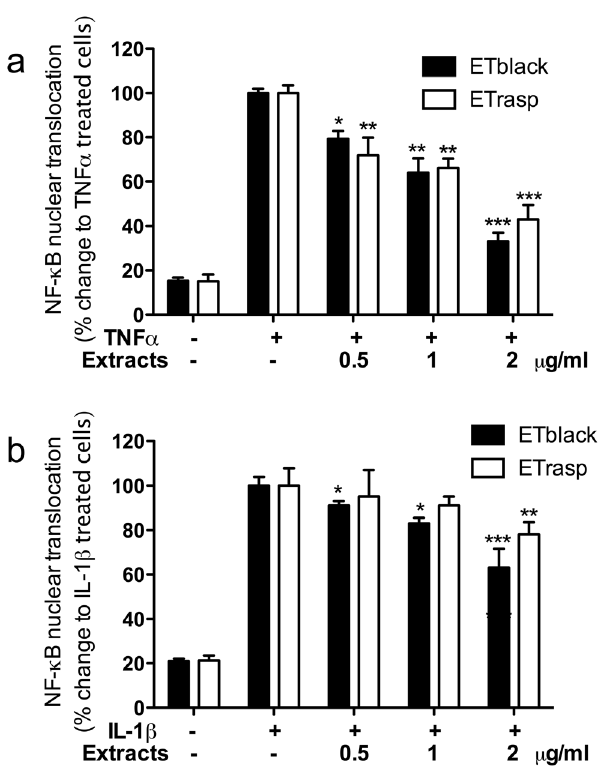
Figure 4. Effect of ETs from blackberry and raspberry on NF- k B nuclear translocation induced by TNF a and IL-1 b . AGS cells at confluence were placed in a medium deprived of FCS, and stimulated with 10 ng/ml TNF- a (panel a) or IL-1 b (panel b) for 1 hr. AGS cells were plated at the concentration of 1.5 6 10 6 cells/ml in 60-mm plates. NF- k B nuclear translocation was assessed using the NF- k B (p65) transcription factor assay kit (Cayman) followed by spectroscopy (signal read 450 nm, 0.1 s). Inhibition by 5 m M parthenolide used as reference inhibitor was 37% on TNF- a induced NF- k B nuclear translocation, and 40% on IL-1 b induced nuclear translocation. Results are the mean 6 sd of three experiments in triplicate. * p , 0.05, ** p , 0.01, ***p , 0.001.